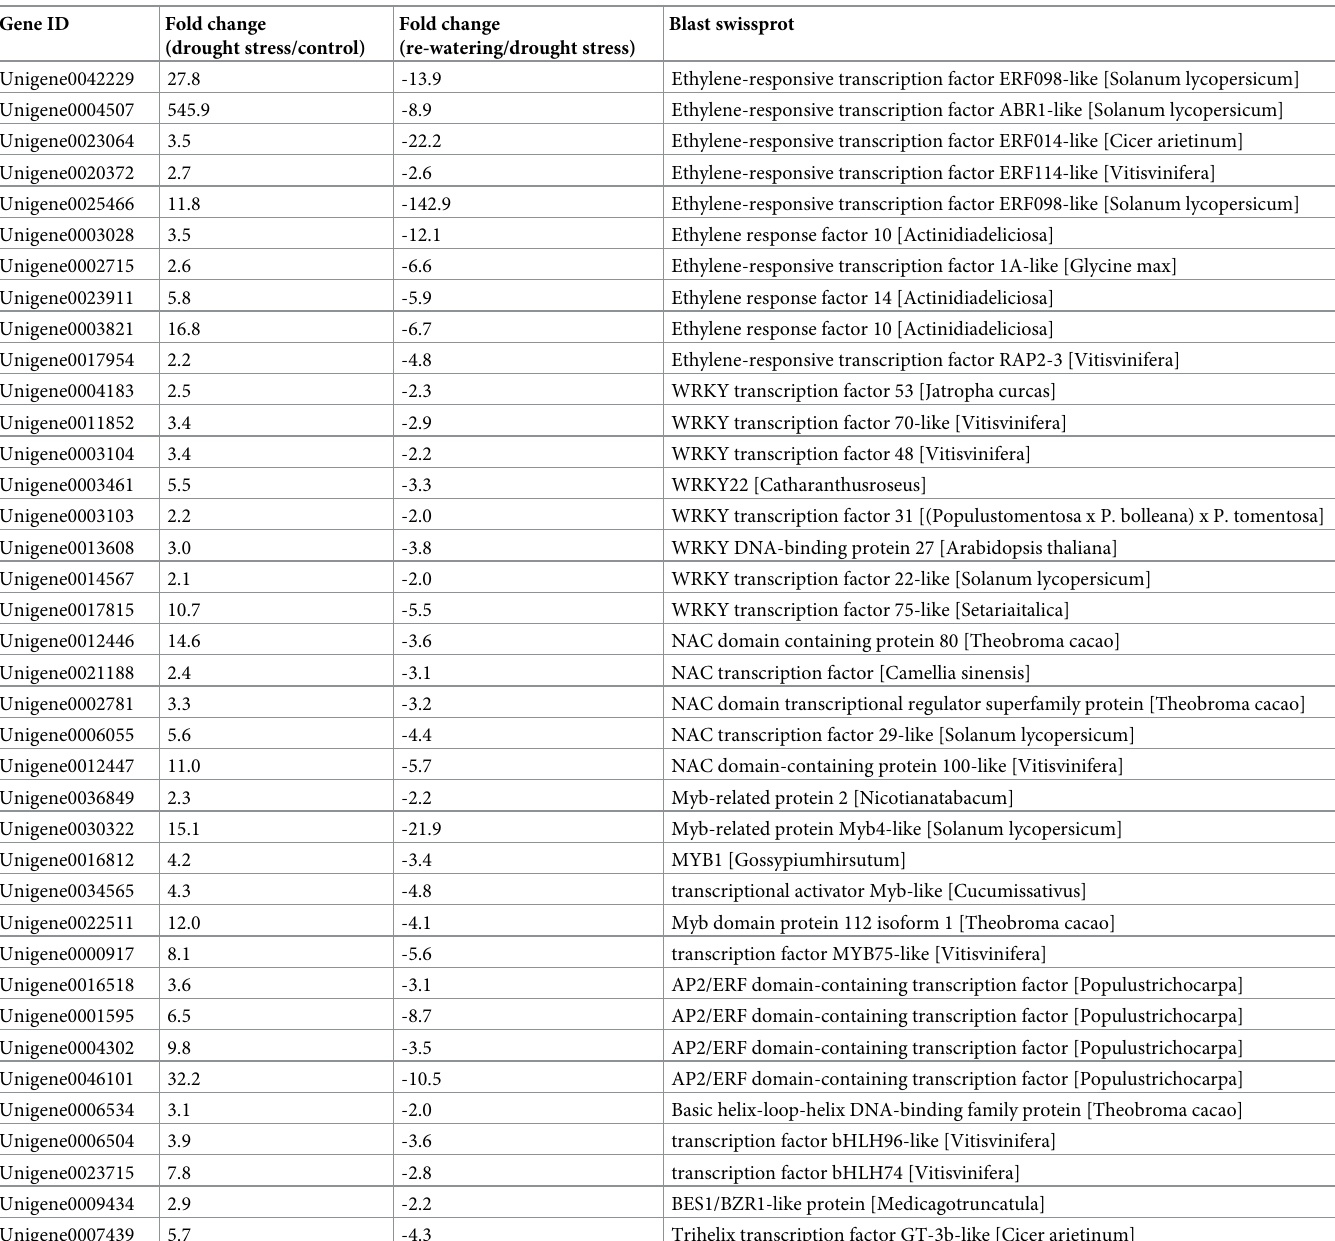
Table 5. The putative TFs genes that were induced by drought stress and repressed by re-watering. Gene ID Fold change (drought